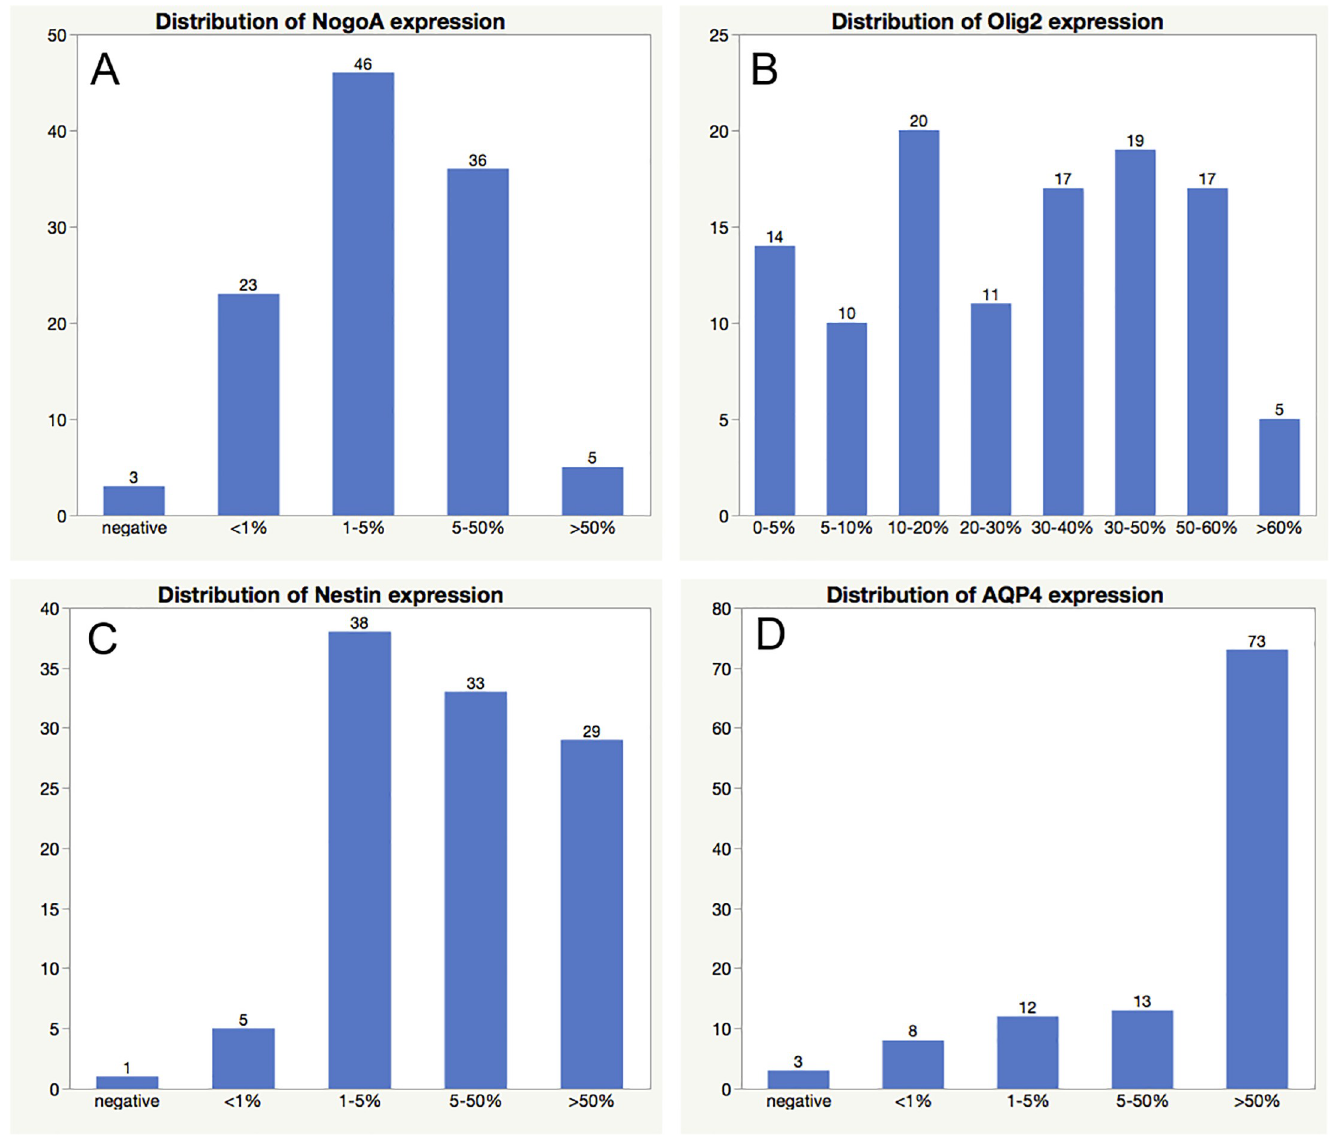
Fig 2. Distribution of the different immunohistochemical scores of each marker (A: NogoA, B: Olig2, C: Nestin, D: AQP4).